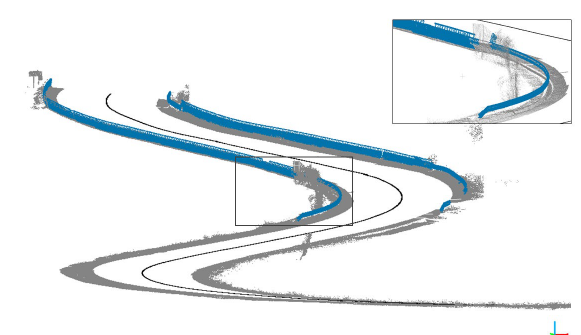
Figure 3. Points belonging to the ROI (in grey) and to the road centreline (in black).